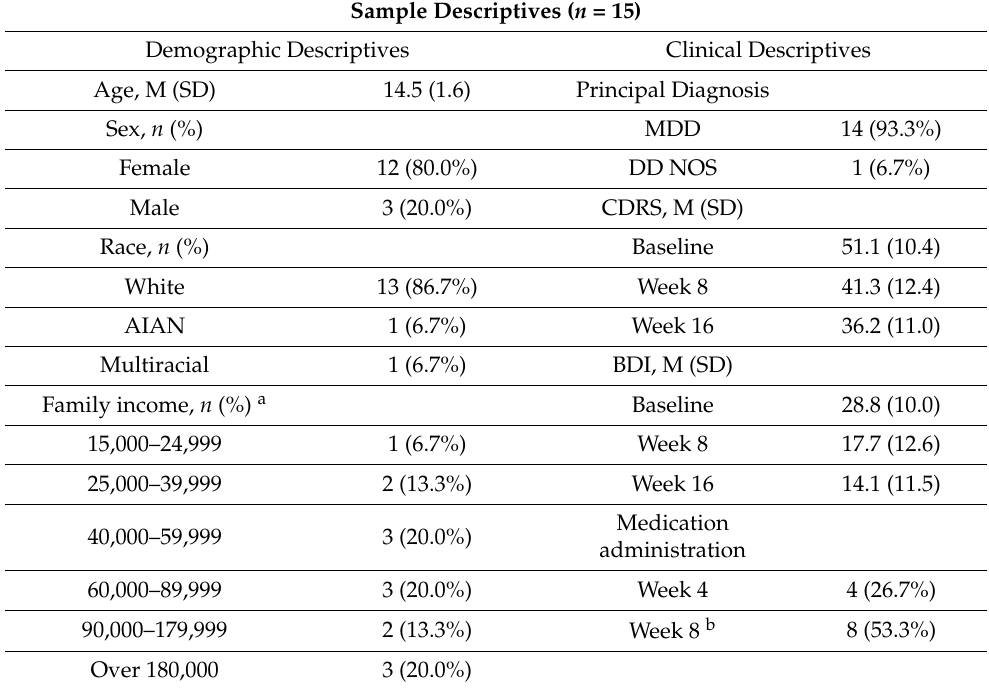
Table 1. Sample Characteristics and Descriptive